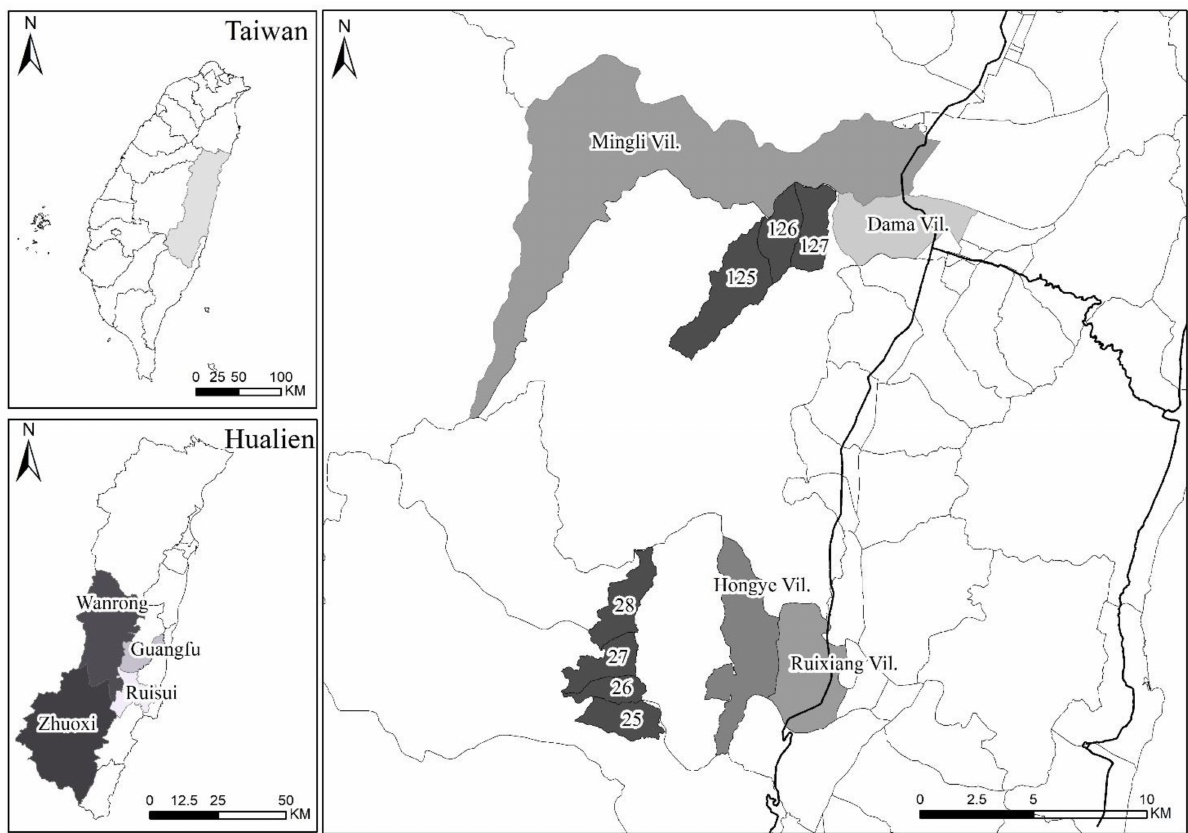
Figure 1. The study area and sampling